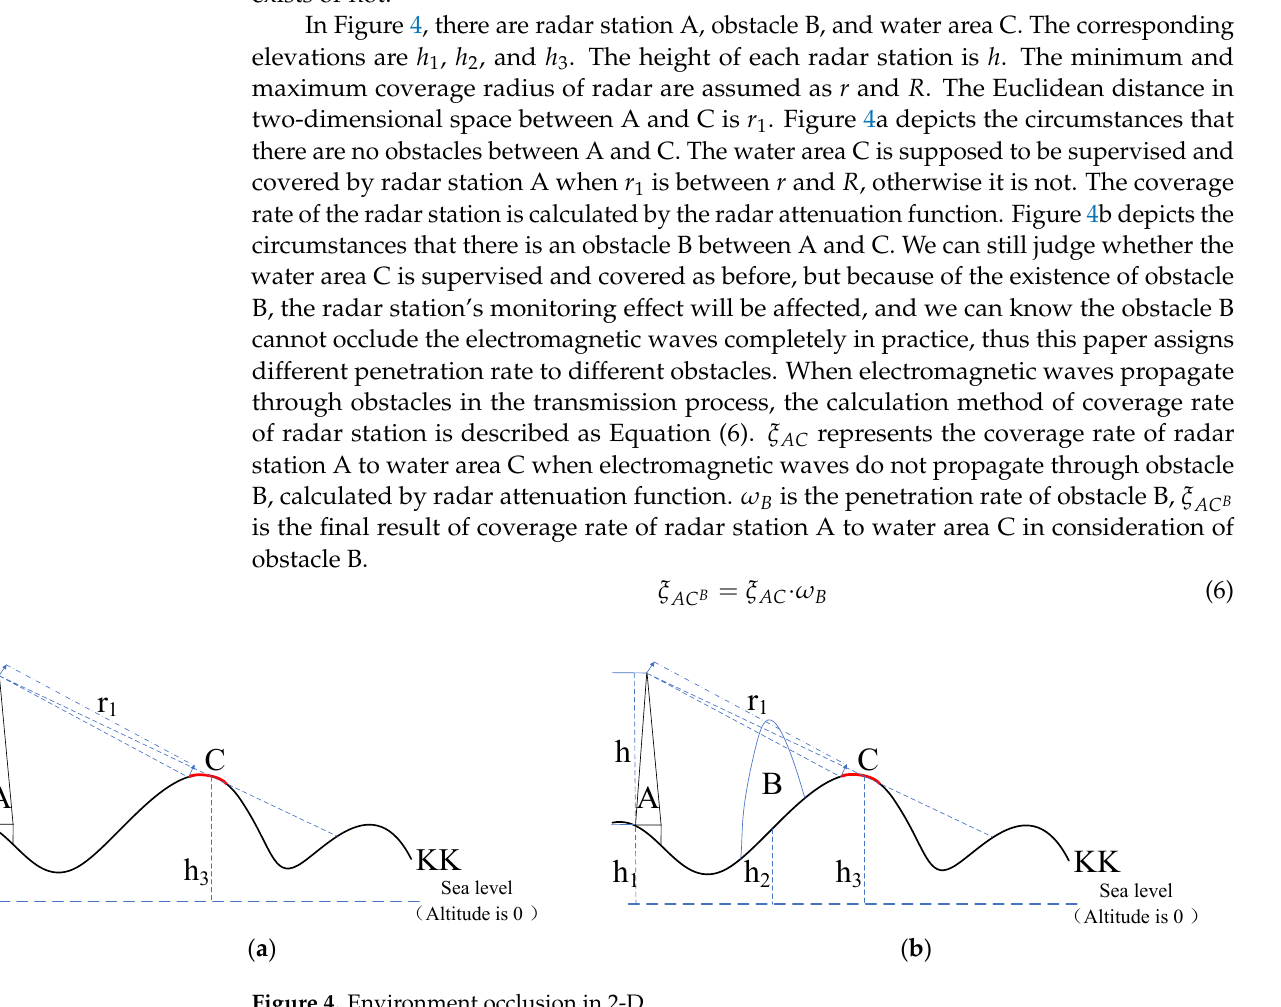
Figure 5. Environmental occlusion.